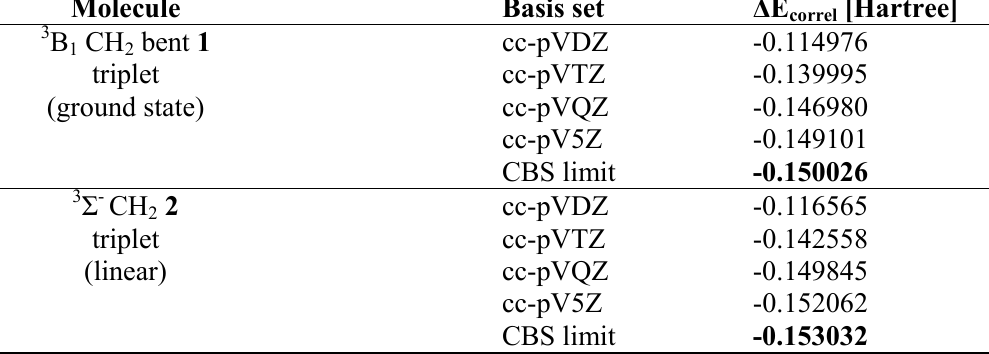
Table 8. Correlation energies obtained as the difference between CCSD(T) and Hartree– Fock total energies [Hartree] ( ∆ E calculations and extrapolations to the CBS